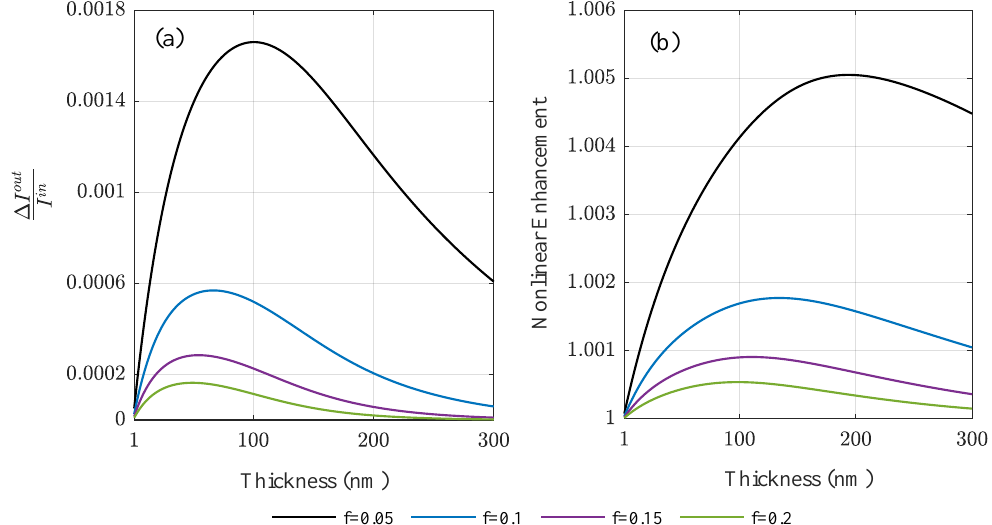
Figure 8. Varying the film thickness of amorphous composite films of different fill fractions f , ( a ) the normalized difference in transmitted intensity ∆ I = I NLO − I lin , and the ( b ) relative intensity enhancement due to nonlinear effects in ultra-thin metallic amorphous films are shown. The incident power density is 1.6 GW / cm 2